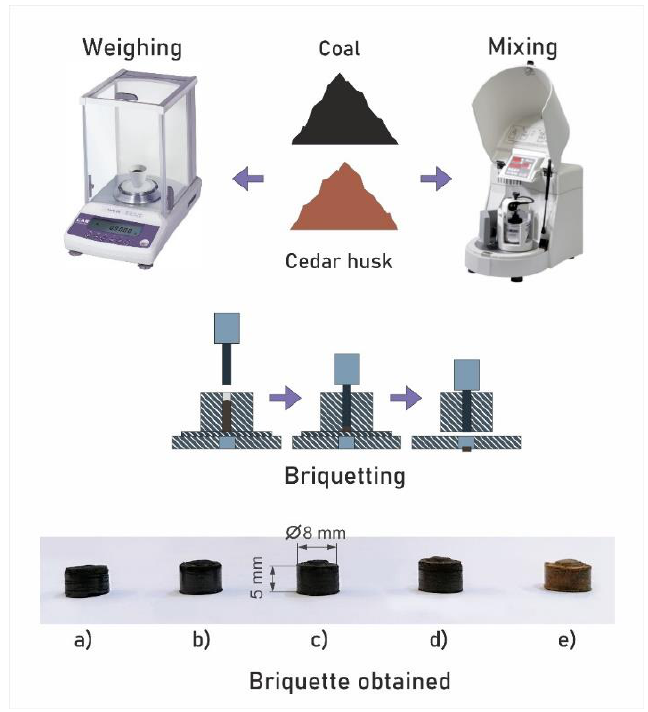
Figure 1. Schematic diagram of the preparation of mixed fuel pellets: ( a ) pellets of homogeneous coal, ( b ) pellets with a cedar husk content of 10%, ( c ) pellets with a cedar husk content of 25%, ( d ) pellets with a cedar husk content of 50%, and ( e ) pellets of homogeneous cedar husk. The granules size shown in Figure 1 was 8 mm in diameter and 5 mm in